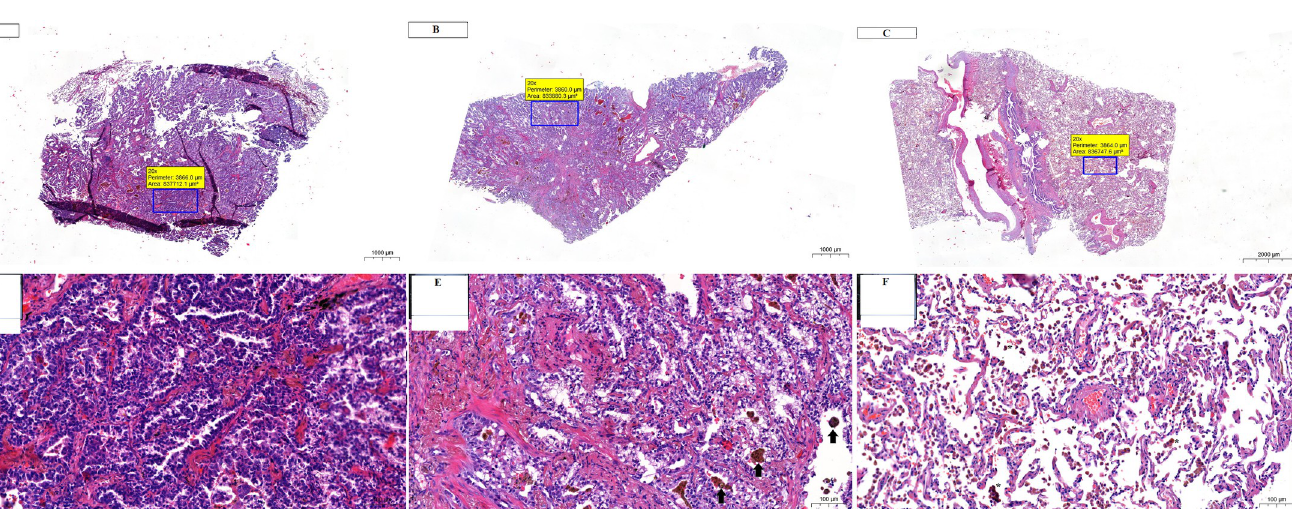
PLOS ONE | https://doi.org/10.1371/journal.pone.0268073 May 5,